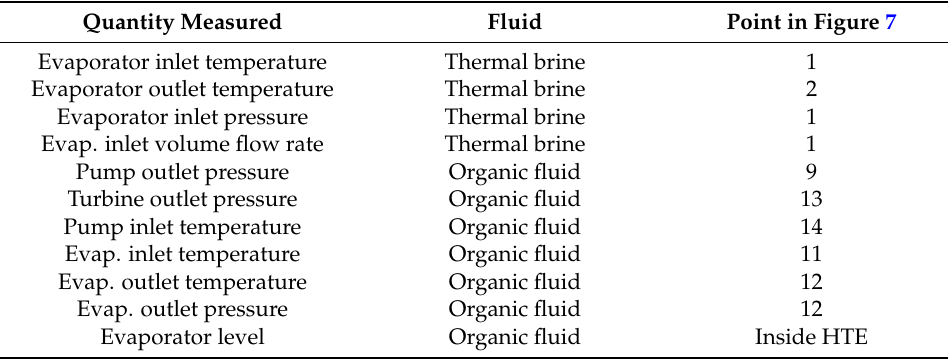
Table 2. Available measurements for the HTE in